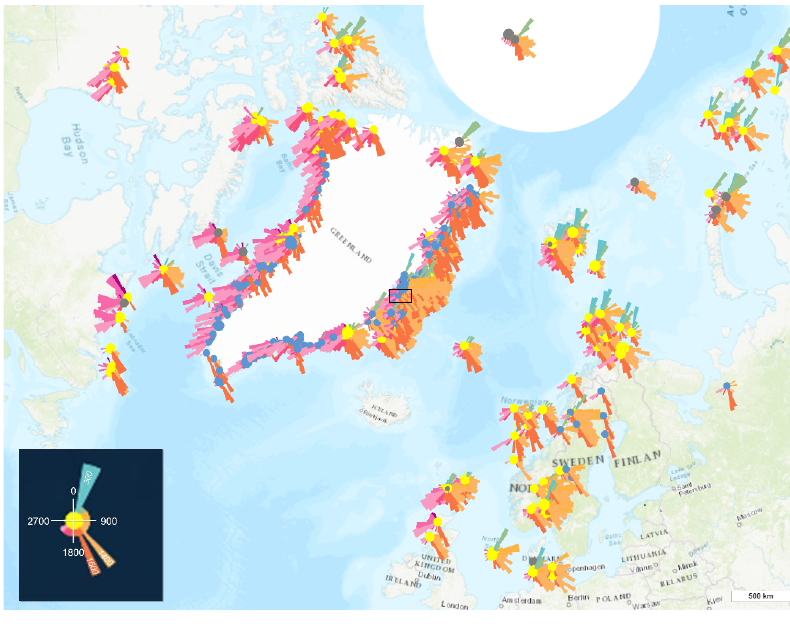
Fig. 1. Output map from the database showing the detrital zircon age distributions available as of July 2019. Each data point (sample) is marked by either a yellow or a blue dot representing a sandstone sample or a present-day drainage sample, respectively. The rosette visualises the age distribution histogram where ‘North’ is 0 Ma and ‘South’ is 1.8 Ga with clockwise in- creasing ages. The length of each bar represents the frequency in 100 Ma bins. Inset: area shown in Fig.